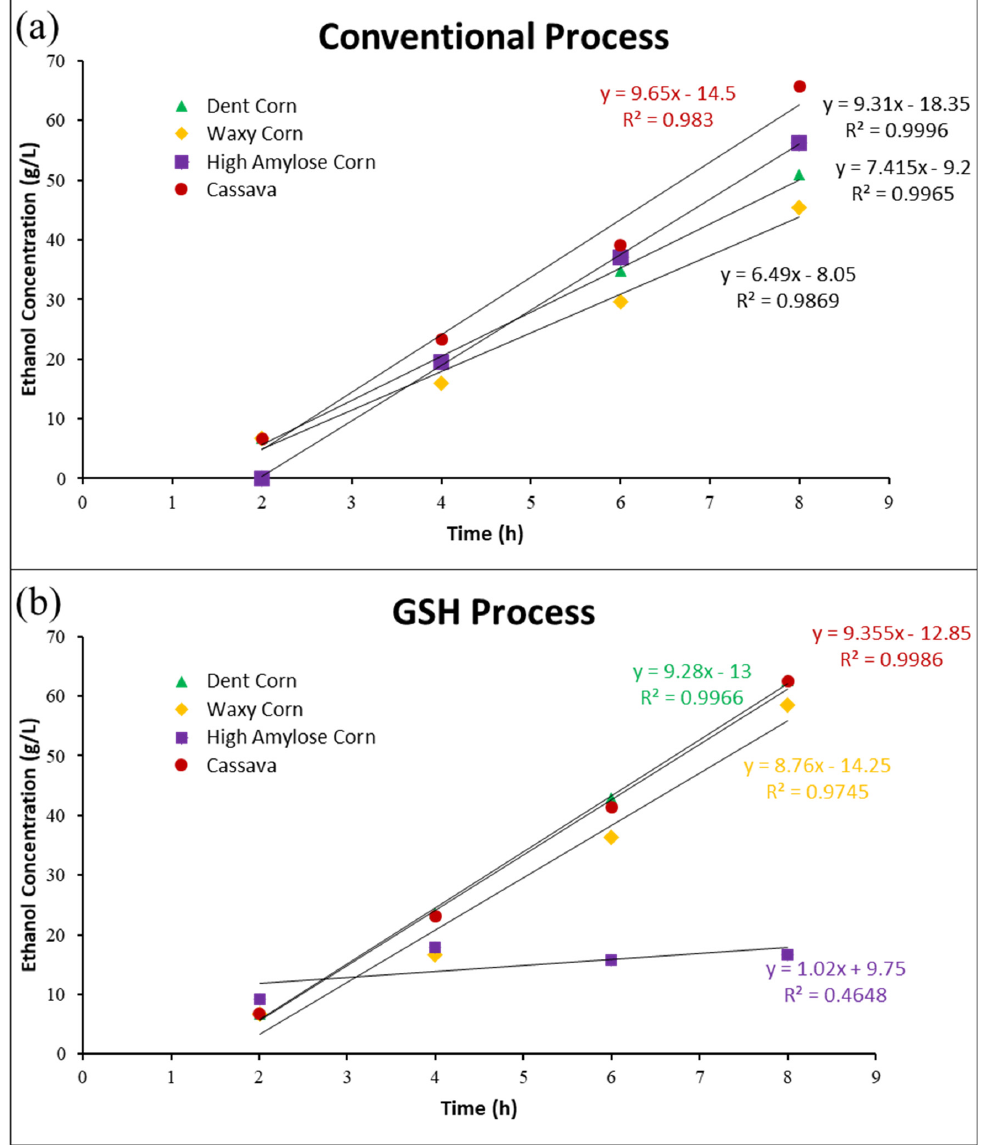
Figure 4. Fermentation rates calculated as slopes of ethanol concentration plotted with time during the first 8 h of fermentation during ( a ) conventional and ( b ) GSH (granular starch hydrolysis) process.